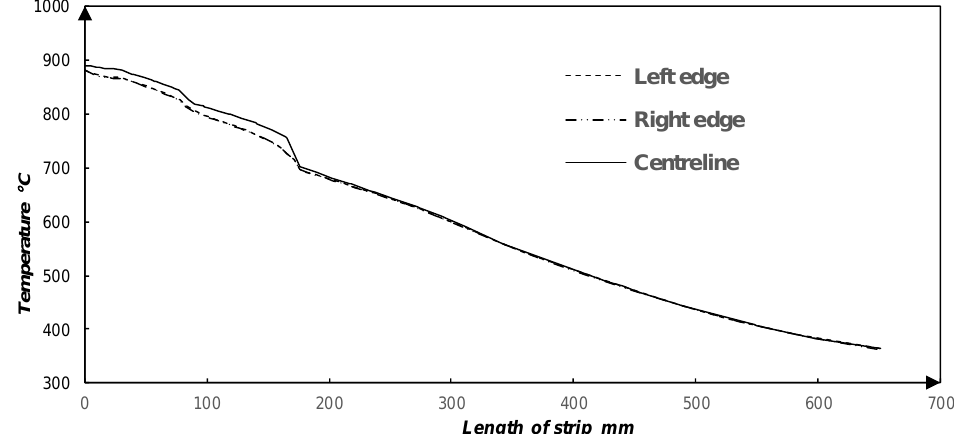
Figure 6. Temperature distribution along the edges and the centre of the strip (°C ) . Gas inlet position: surface A in Figure 2, 𝑄 = 2.66 Nm 3 /h , Strip velocity = 𝑣 𝑆𝑡𝑟𝑖𝑝 (< 0.17 m/s) .